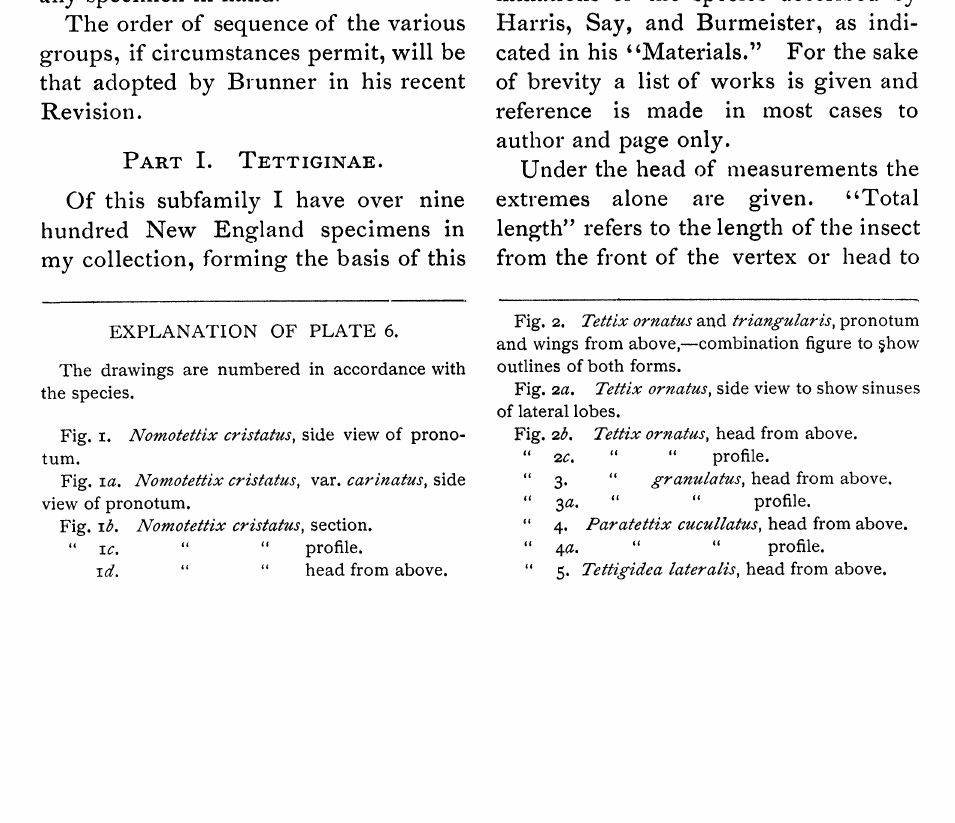
Fig. 2. Tettix ornatus and trianularis, pronotum and wings from above,combination figure to how . outlines of both forms. Fig. 2a. Tettix ornatus, side view to show sinuses of lateral lobes. Tettix ornaus, head from above. Fig. c.